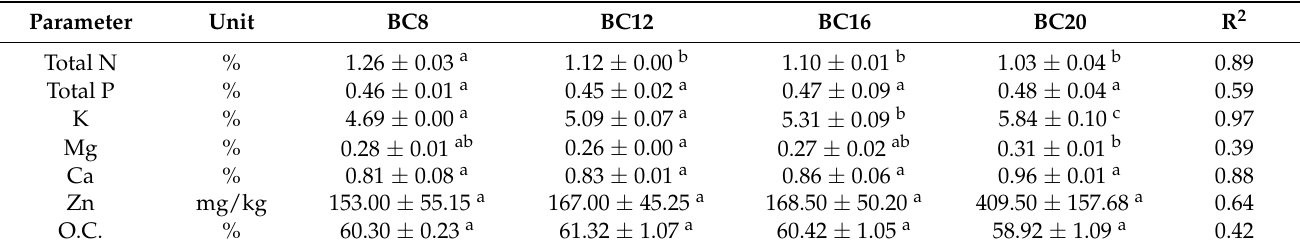
Table 3. Airflow effect on wild sugarcane biochar